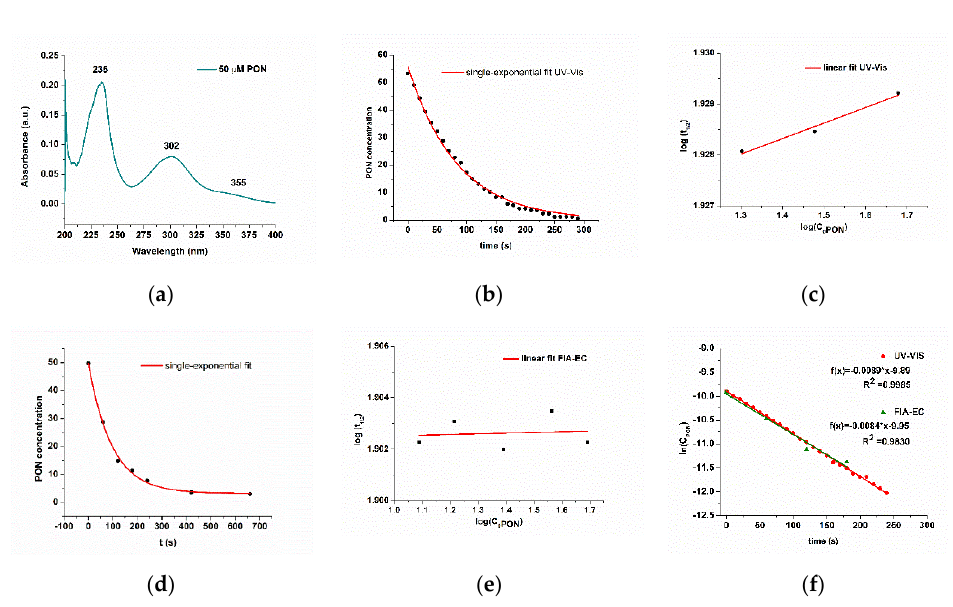
Figure 10. ( a ) UV-Vis spectra of 50 µM PON, pH 9, PBS 0.1 M. The illustration of the second method “half-lives method”: plot of C PON vs. time , fitted with a single-exponential equation (y = y 0 ∙e −kx ) for the data obtained using ( b ) the UV-Vis method and ( d ) our proposed FIA-EC method. Plot of log(C 0PON ) vs. log(t 1/2 ) from ( c ) UV-Vis and from ( e ) FIA-EC, fitted linearly for the determination of apparent reaction order from the slope of the equation (Method B). The illustration of the first method (Method A): ( f ) plot of ln(C PON ) vs. time according to pseudo first order, fitted linearly for both UV-Vis and our proposed FIA-EC method (linear correlation function, R 2 linear correlation coefficient and apparent kinetic constant is determined from these plots, data presented in Table 2). All spectra represent the data for 50 µM PON, pH 9, PBS 0.1 M. Table 2. Calculated pseudo first-order decay rates constants for PON, in PBS pH 9 (0.1M), at 25 °C, determined using classical UV-Vis method at 302 nm and the FIA-EC method, using the SPCE/CoPc (Method A). Pseudo First-Order Decay Rates